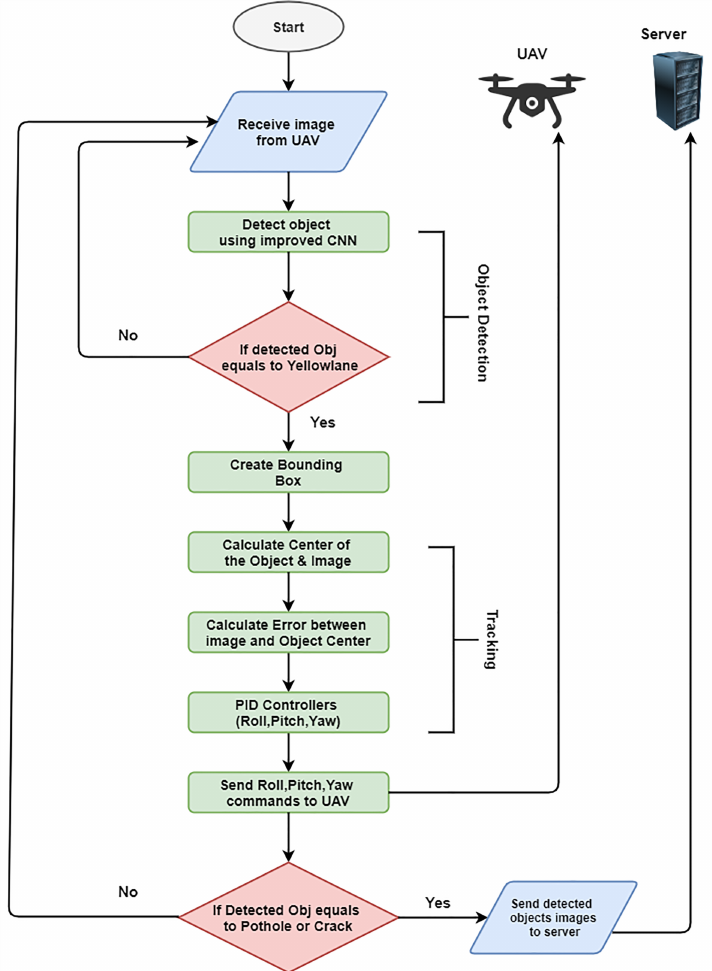
Figure 1. Flowchart of the proposed system.